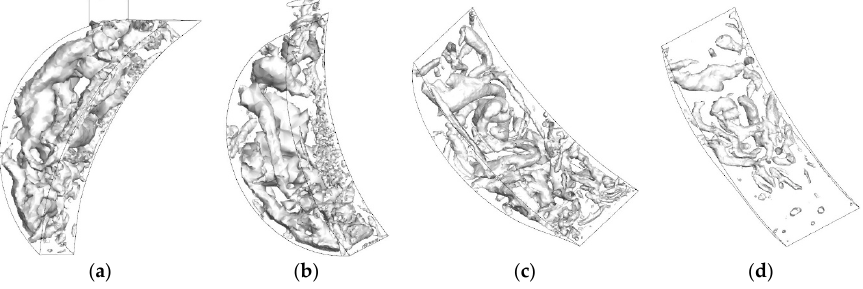
Figure 8. Vortex fields with different CA at 15,000 r/min (Q = 10 7 s − 1 ). ( a ) CA = 360° BTDC; ( b ) CA = 245° BTDC; ( c ) CA = 135° BTDC; ( d ) CA = 45° BTDC.